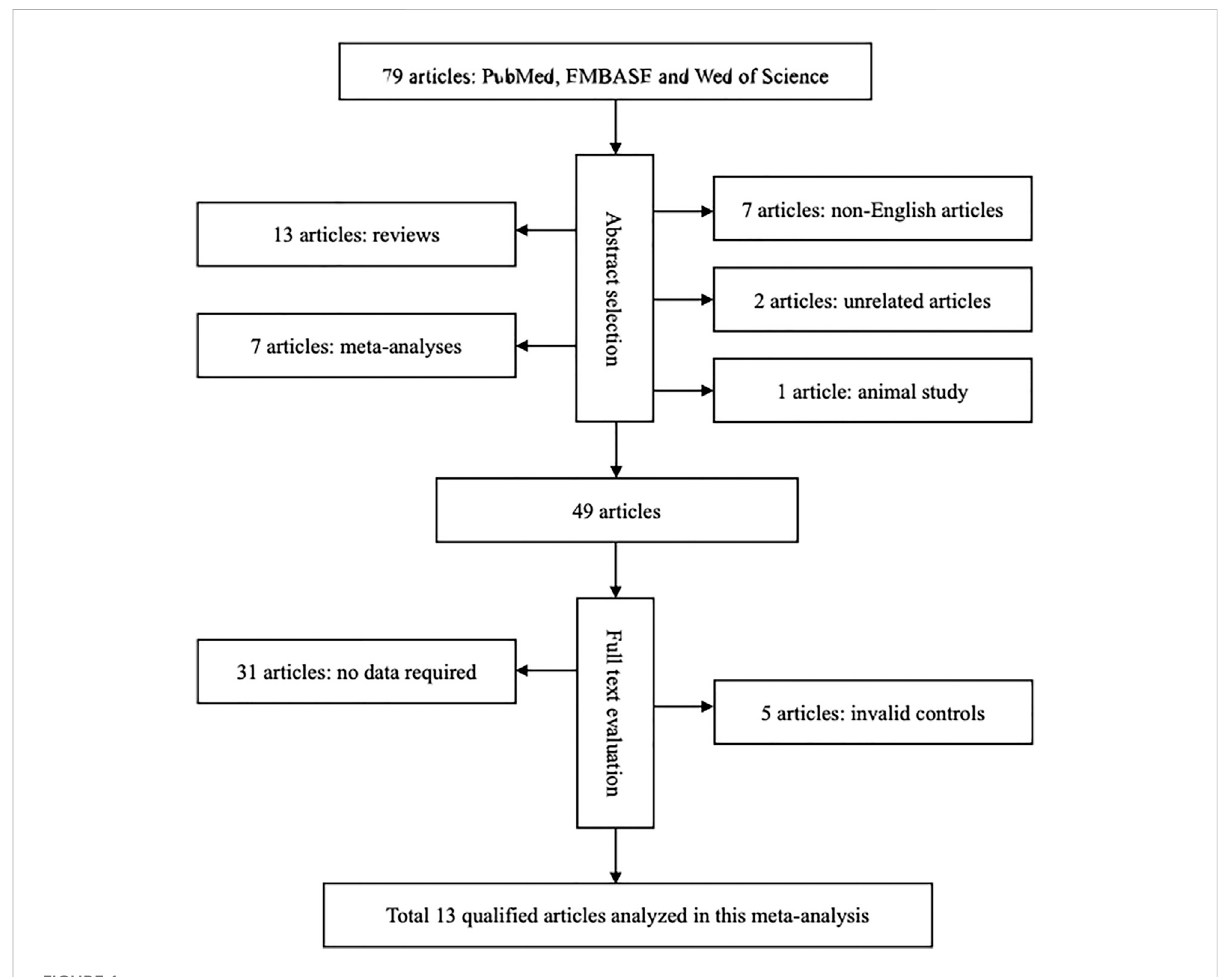
FIGURE 1 Flow diagram for the selection of quali fi ed